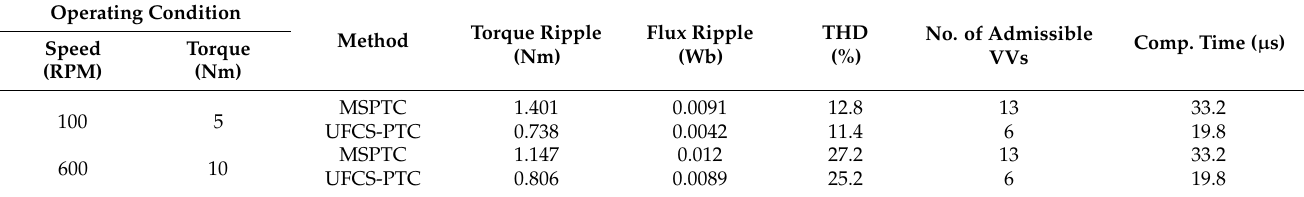
Table 5. Quantitative comparison for UFCS-PTC and MSPTC.